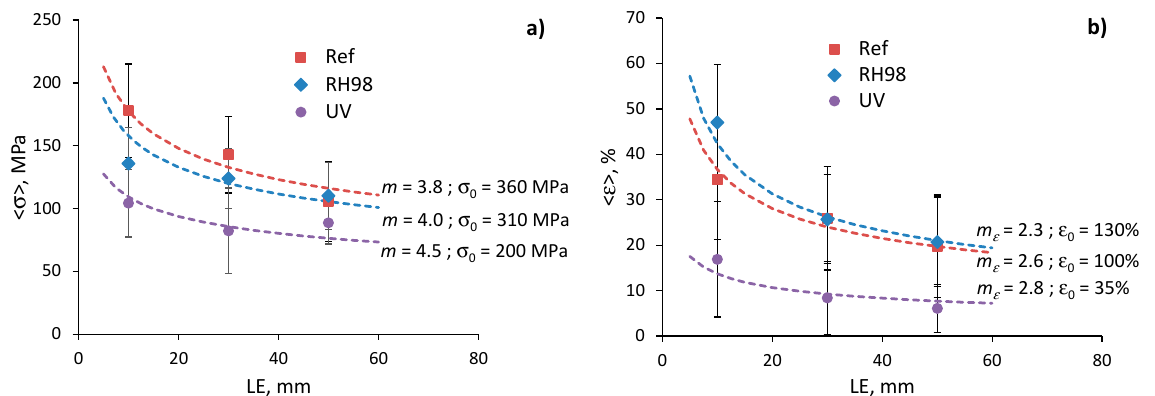
Figure 11. Strength ( a ) and failure strain ( b ) as functions of the gauge length of fibers from different environments. Solid lines are calculations by Equations (5) and (7), respectively; α = 1.